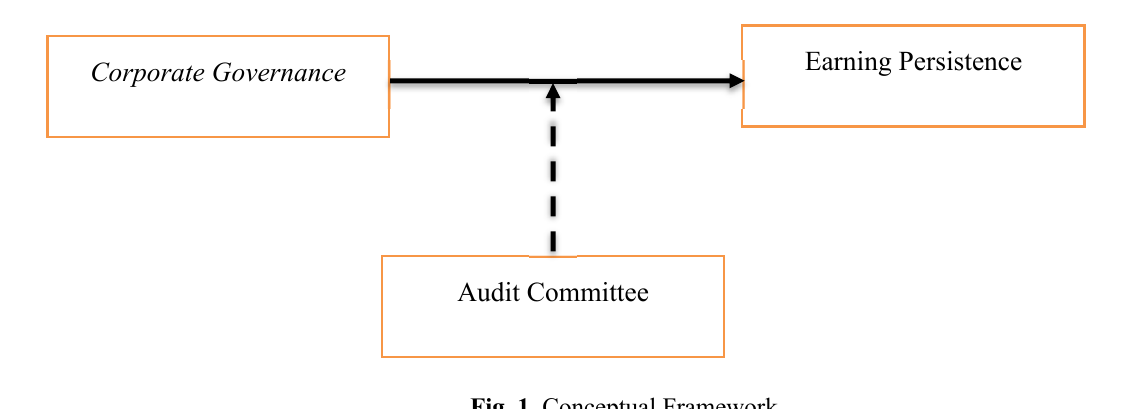
Fig. 1. Conceptual